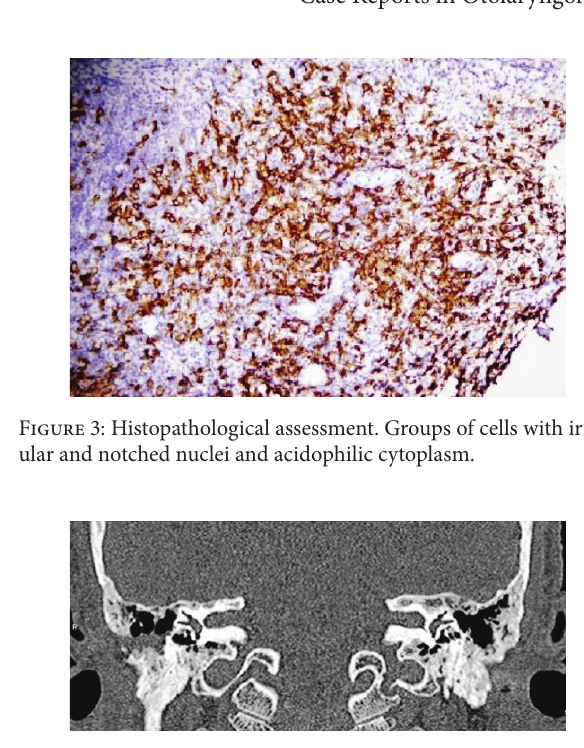
Figure 4: Postoperative CT scan. Note the absence of lytic lesion in left petrous apex and superior semicircular